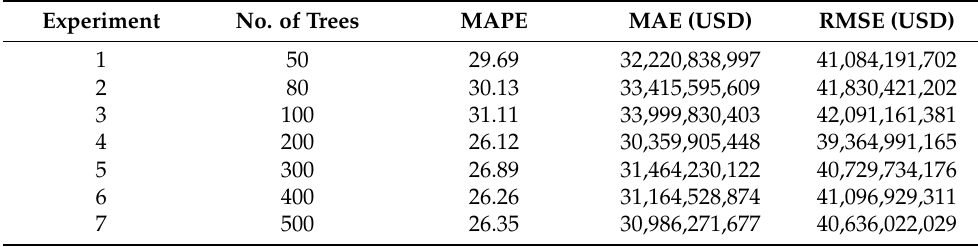
Table 2. Revenue loss prediction error of different experiments for the winter storm category. Experiment No. of